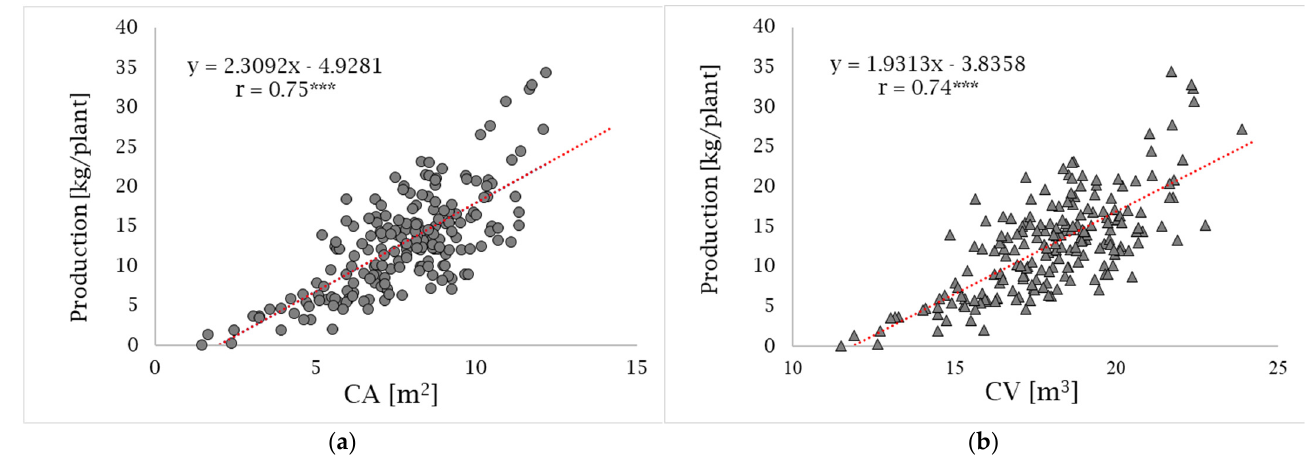
Figure 11. ( a ) Correlation between CA and Production; ( b ) correlation between CV and Production.